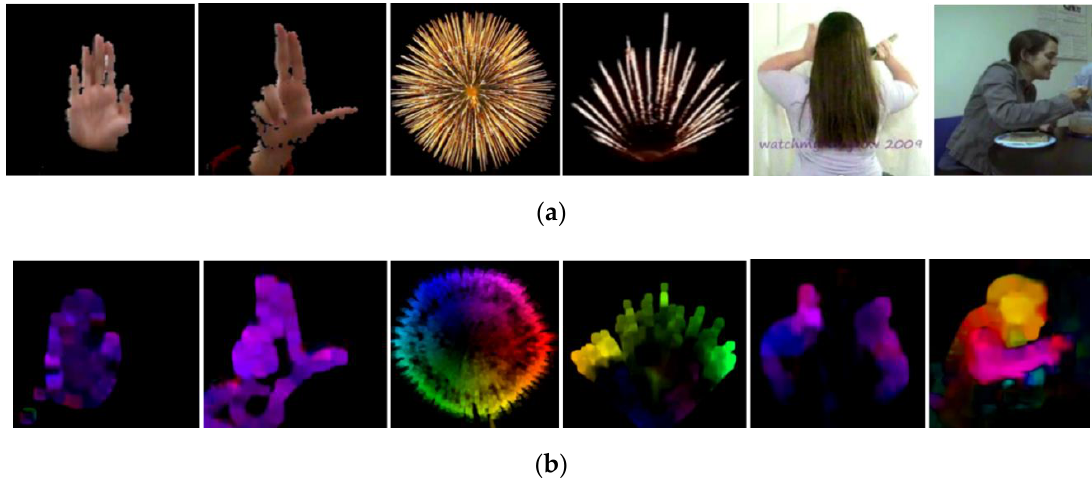
Figure 4. Sample RGB and optical flow frames. We colored the optical flow results with Hue value for better visualization. ( a ) RGB frames of three datasets; ( b ) Optical flow frames of relevant RGB frames.